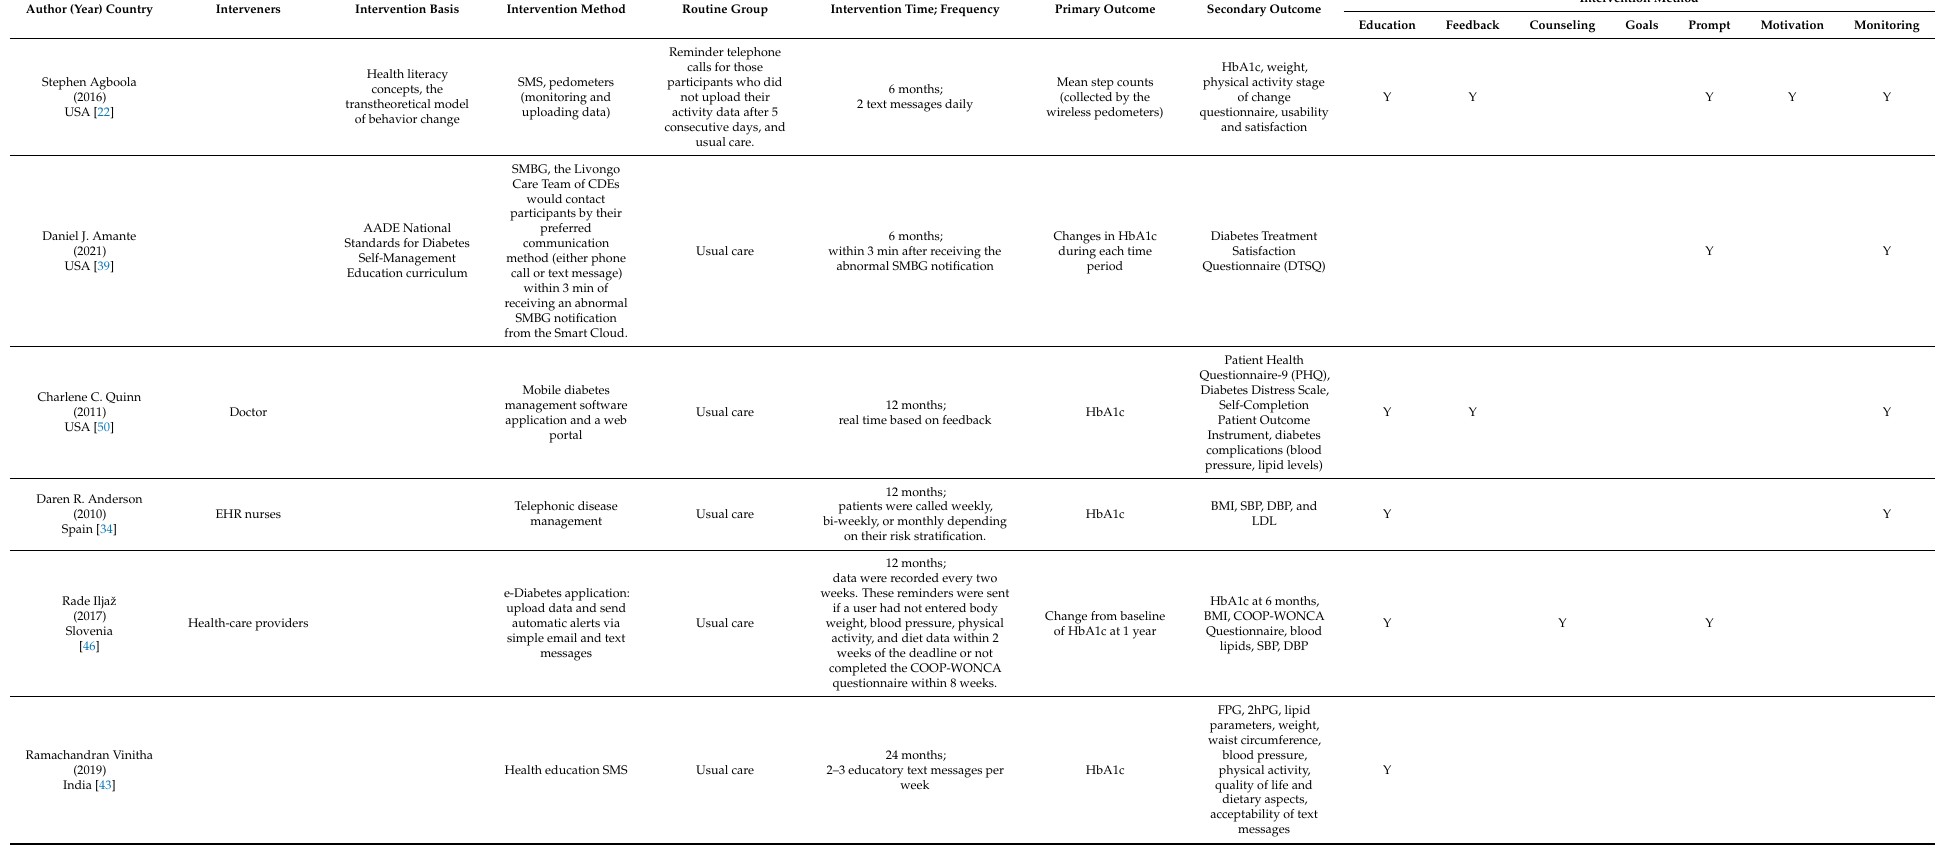
Table 1. Characteristics of telemedicine